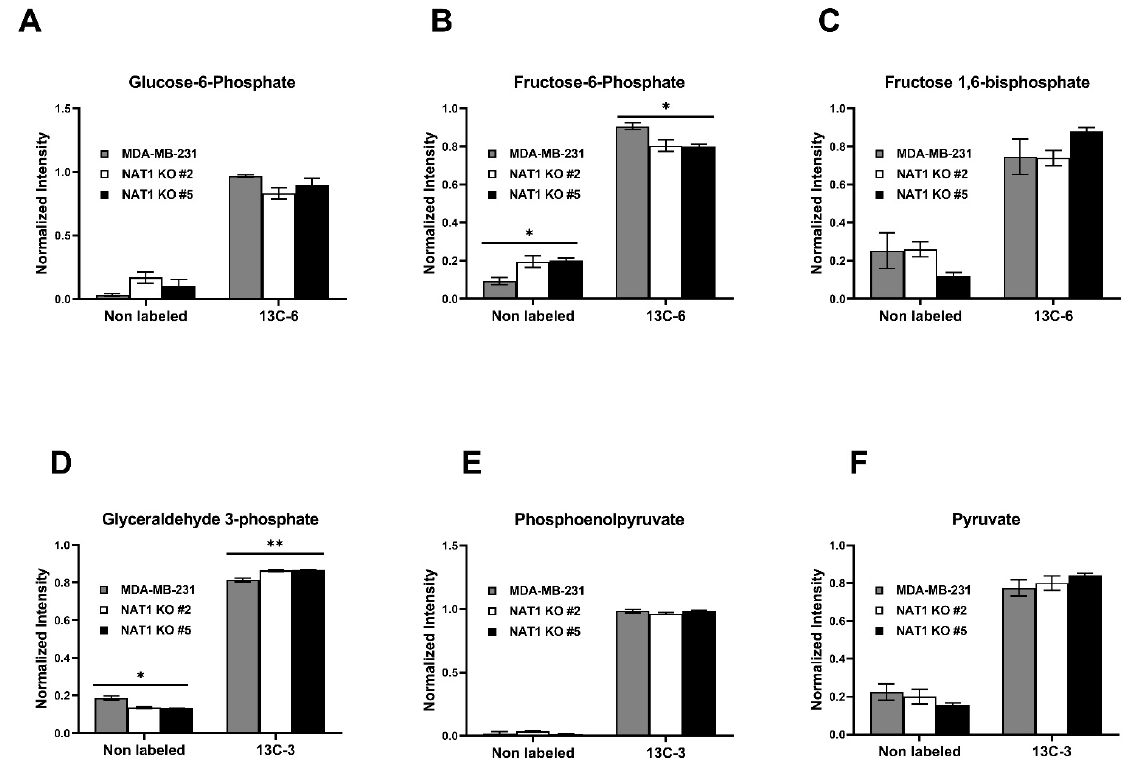
Figure 3. N -Acetyltransferase 1 Knockout E ff ect on the Glycolytic Intermediates in MDA-MB-231 Cells . Carbon-13 enrichment of glycolytic intermediates was measured in MDA-MB-231 cells and NAT1 KO #2 and #5 after 24 h incubation with [ 13 C]-glucose. Data are presented for both unlabeled [ 12 C] and detected [ 13 C]-labeled metabolites ( A ) Glucose-6-Phosphate ( 13 C-6) ( B ) Fructose-6-Phos- phate ( 13 C-6) ( C ) Fructose 1,6-Bisphosphate ( 13 C-6) ( D ) Glyceraldehyde 3-Phosphate ( 13 C-3) ( E ) Phos- phoenolpyruvate ( 13 C-3) ( F ) Pyruvate ( 13 C-3). Data represent average of at least 3 experiments ± SEM, * q < 0.05 and ** q < 0.01 compared to MDA-MB-231.